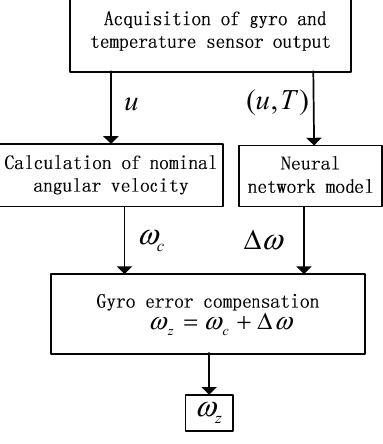
Figure 4. The flow of gyro angular velocity error